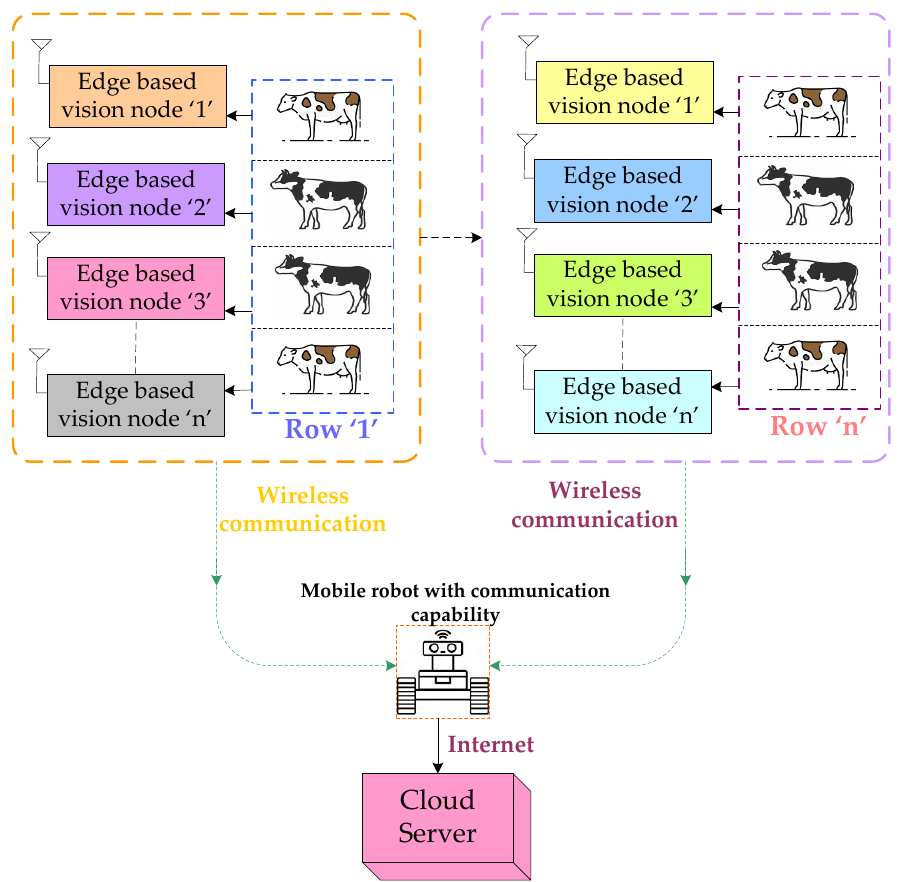
Figure 4. Architecture implemented in previous studies for animal health monitoring.